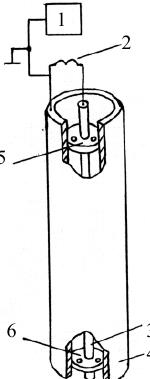
Fig. 7. Scheme with RF